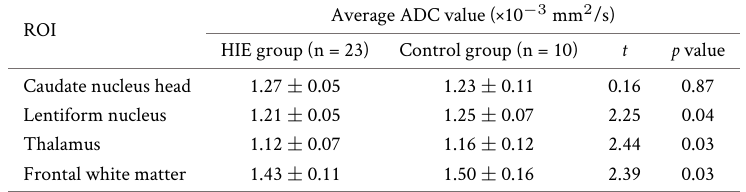
Table 3. The average ADC values in different brain areas of neonates (mean ± SD).